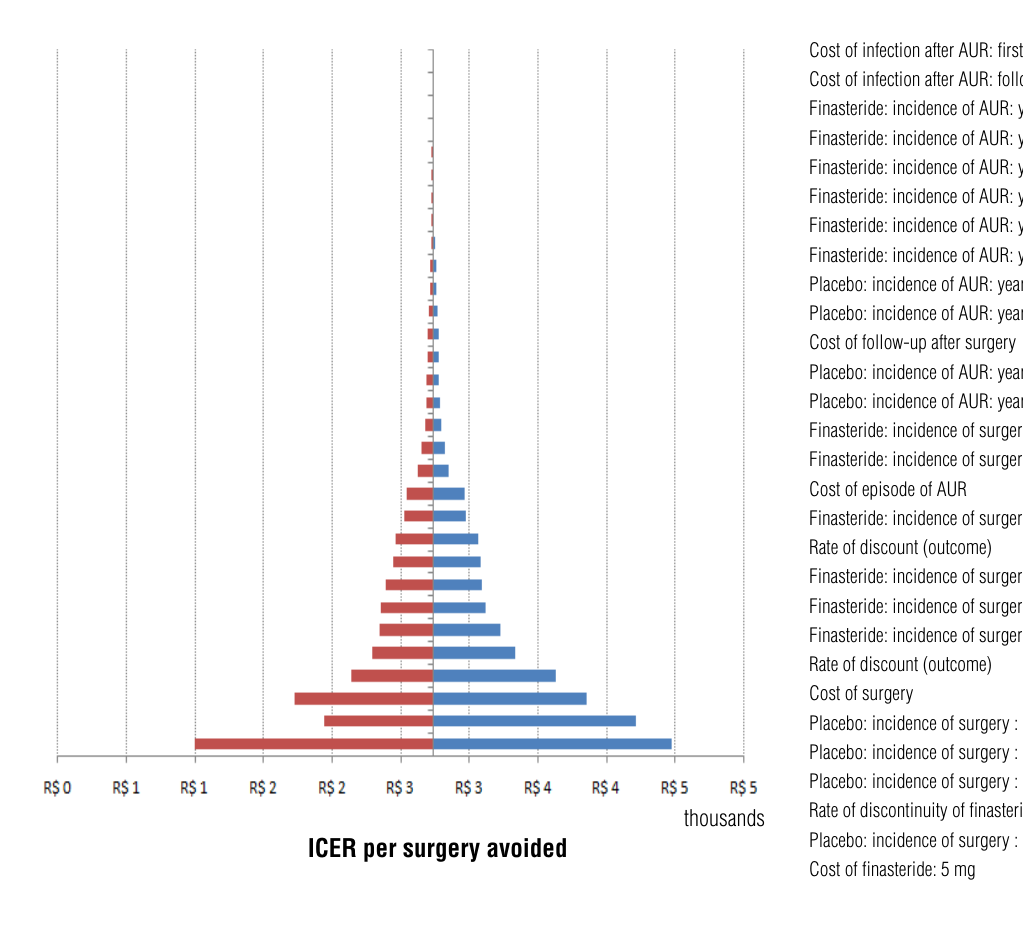
Figure 2 - Tornado figure (finasteride versus placebo in a period of 6 Figure 2 – Tornado graph (finasteride or placebo in a 6 year period).